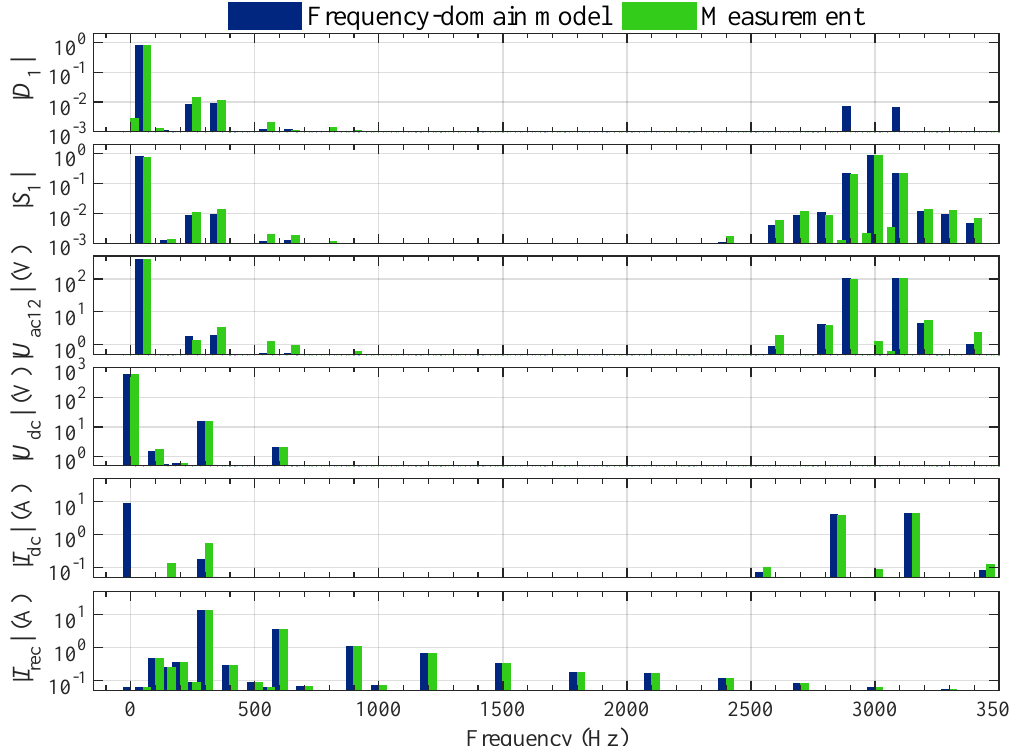
Figure 13. Comparison of frequency-domain model and measurements for a three-phase VSI with closed-loop control for Case